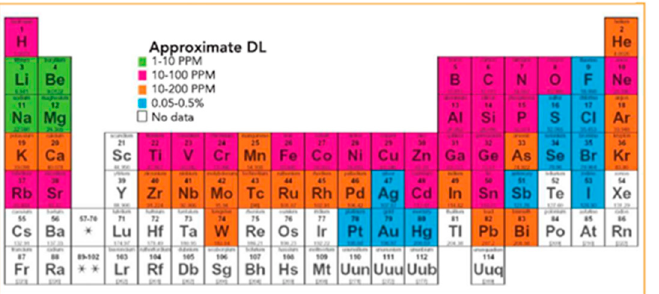
Figure 10. Detection limits for different elements obtainable by a commercial LIBS system [92]. Copyright 2022 Kimberly